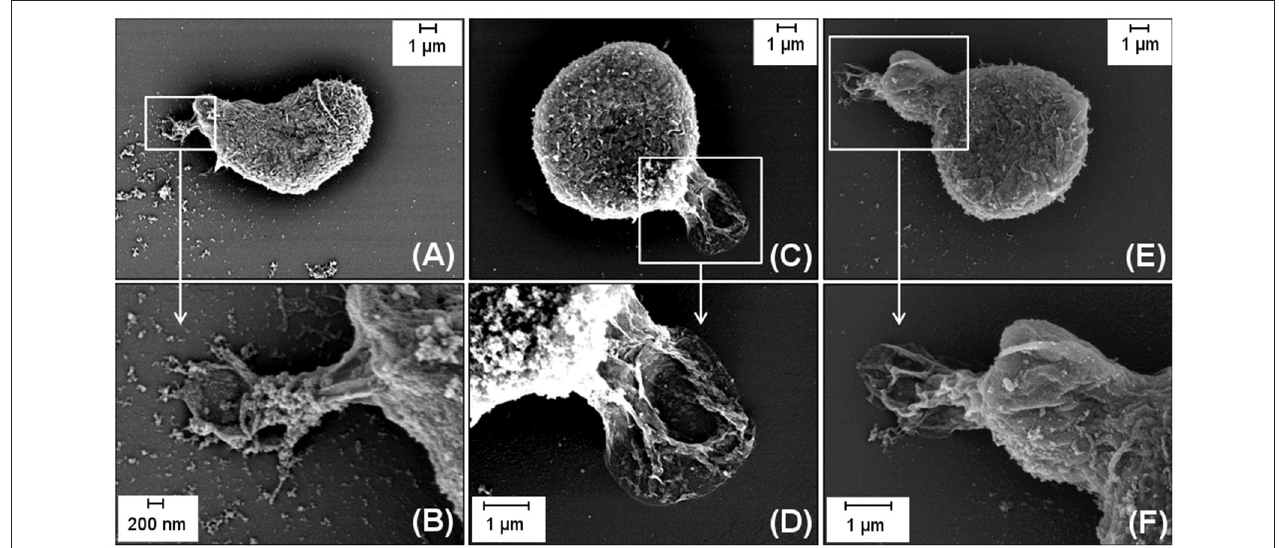
FIGURE 2 | Representative SEM micrographs with different magnifications displaying the adhesive behavior of CD34 + cells seeded on a DLL1/RGD functionalized hydrogel with an average interparticle distance of 40nm. In the upper row (A,C,E) representative images showing one entire cell are depicted. The encircled areas (white rectangles) are magnified in the images displayed in the lower row (B,D,F) . (B) shows the magnification of the encircled area of (A) , (D) of (C) and (F) of (E) . Scale bars (A,C,D,E,F) : 1 µ m; (B) :